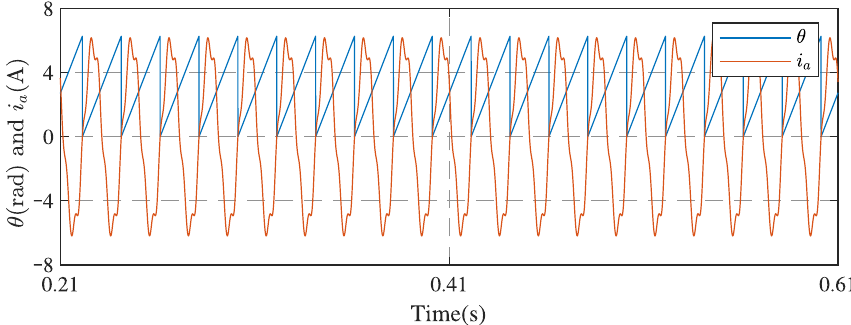
Figure 5. Simulation results of comparison between θ and i a